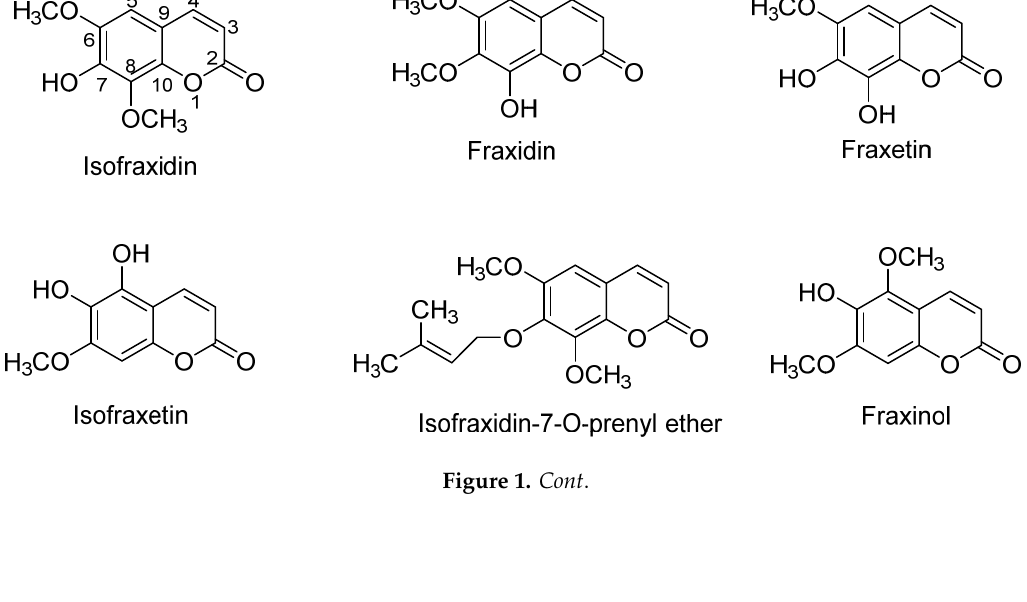
Figure 1. Chemical structure of Isofraxidin (7-hydroxy-6, 8-dimethoxy coumarin) (IF) and other selected coumarin compounds. 2. Isofraxidin 2.1. Natural Sources Isofraxidin is a hydroxy coumarin compound with IUPAC name of 7-Hydroxy-6, 8-dimethoxy-2 H -1-benzopyran-2-one (C 11 H 10 O 5 ) and molecular weight of 222.19 g/mol (Figure 1). The needles crystalline of IF is predominantly present in a white to yellow color, while it is reported as colorless in some studies, possessing a melting point of 145–150 °C [38–40]. The history of isolation and identification of IF dates back to 1937 from the bark of the ash tree ( Fraxinus exelsior, Oleaceae) by Spath and Jerzmanowska [41,42]. Since then, this compound has been isolated from numerous plant families including Apiaceae, Asteraceae, Oleaceae, Rubiaceae, etc. On the other hand, Achillea, Artemisia, Fraxinus, and Ixora are among the known genera in which IF has been isolated from root, stem bark, leave, and aerial parts of their species [43,44]. Table 1 shows some herbs and related parts of those families, which IF is separated from them. Acanthopanax senticosus and Eleutherococcus senticosus (Siberian ginseng, Ciwujia) from the Araliaceae family have been used as medicinal plants in chines since several years ago. IF has been extensively isolated from this plant regarding its pharmacological and therapeutic effects [45]. Also, as shown in Table 1, species of the genus Artemisia from the Asteraceae family have the highest abundance in terms of IF isolation. In addition to plant sources, IF has also been found in fungi, as was isolated from an endophytic fungus, Biscogniauxia cylindrospora by Wu et al. [46].